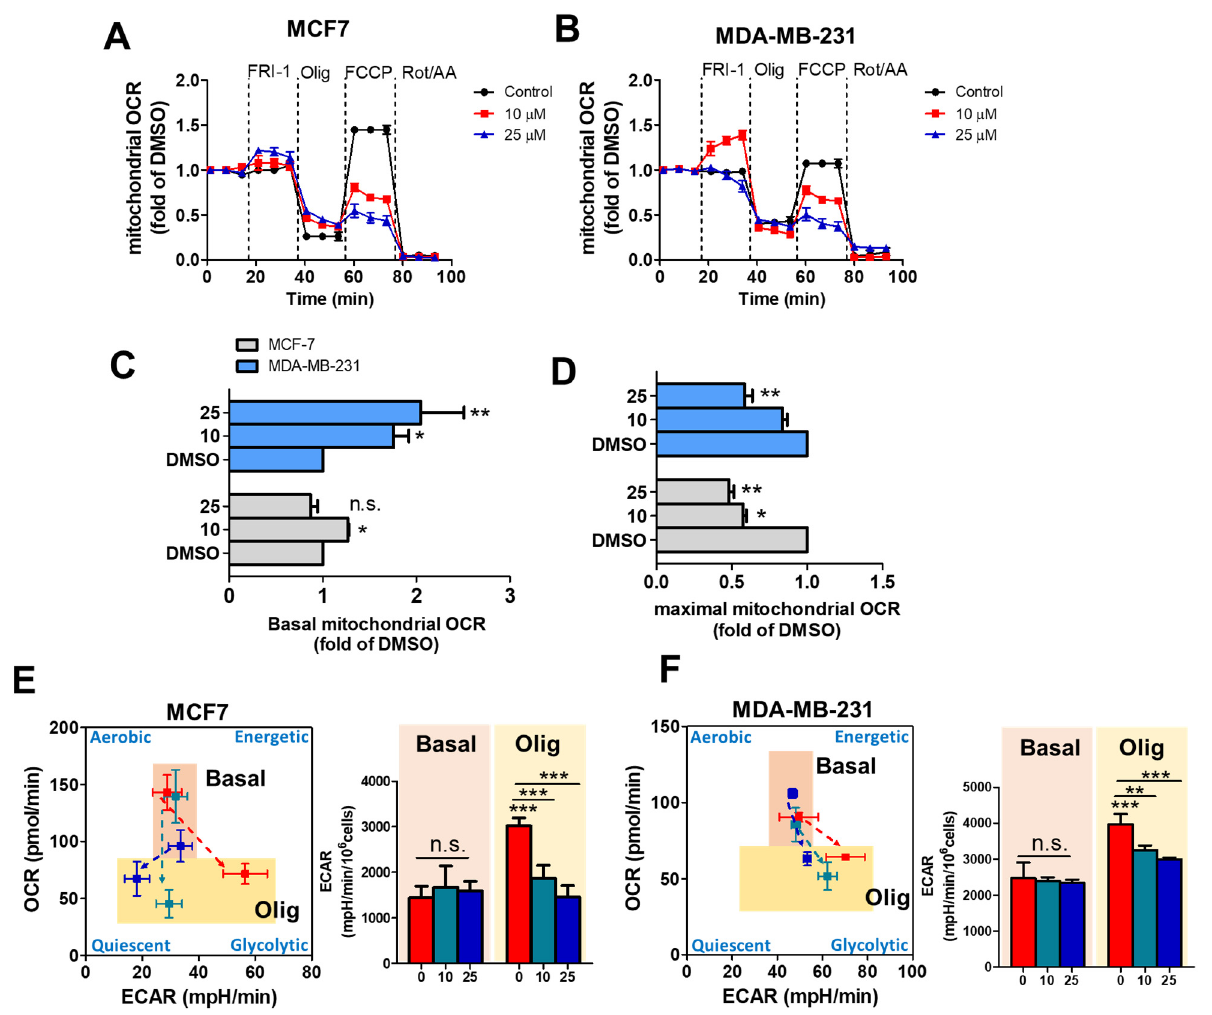
Figure 3. FRI-1 inhibits the metabolism of breast cancer cells. ( A , B ) Profile of mitochondrial respiration produced by FRI-1, oligomycin, FCCP, and rotenone/antimycin A injections; ( C , D ) Effect of FRI-1 on basal and maximal oxygen consumption rate (OCR) of BC cells; ( E , F ) Inhibition of oligomycin-induced metabolic remodeling by FRI-1 in MCF7 and MDA-MB-231 breast cancer cells. Data are shown as the mean ± SD of three independent experiments. * p < 0.05, ** p < 0.01, *** p < 0.001, vs. control (DMSO). n.s.: not significant.